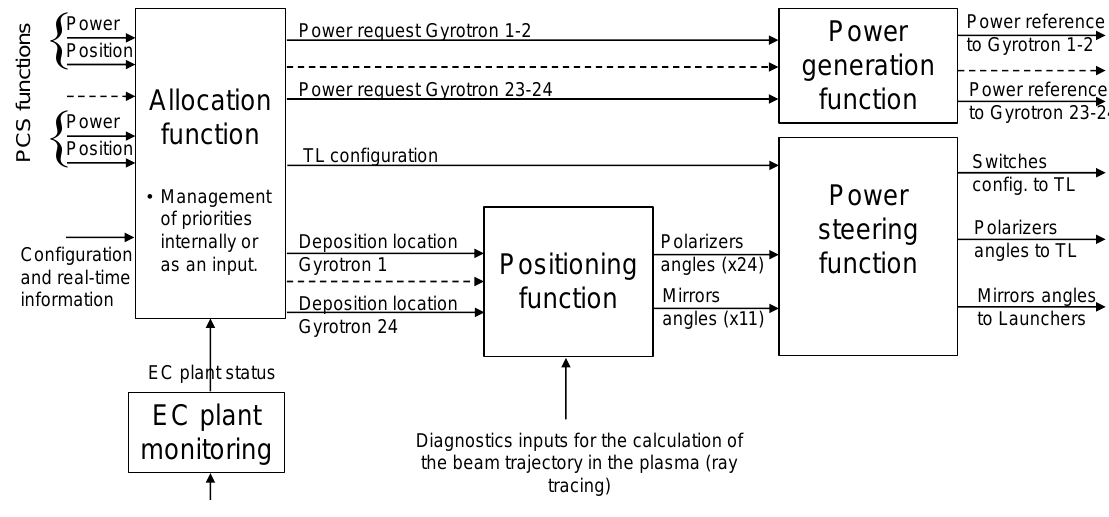
Fig. 5. EC system functional